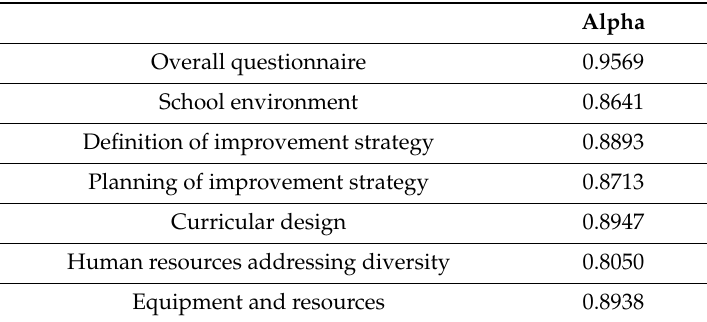
Table 2. Table of Cronbach alpha